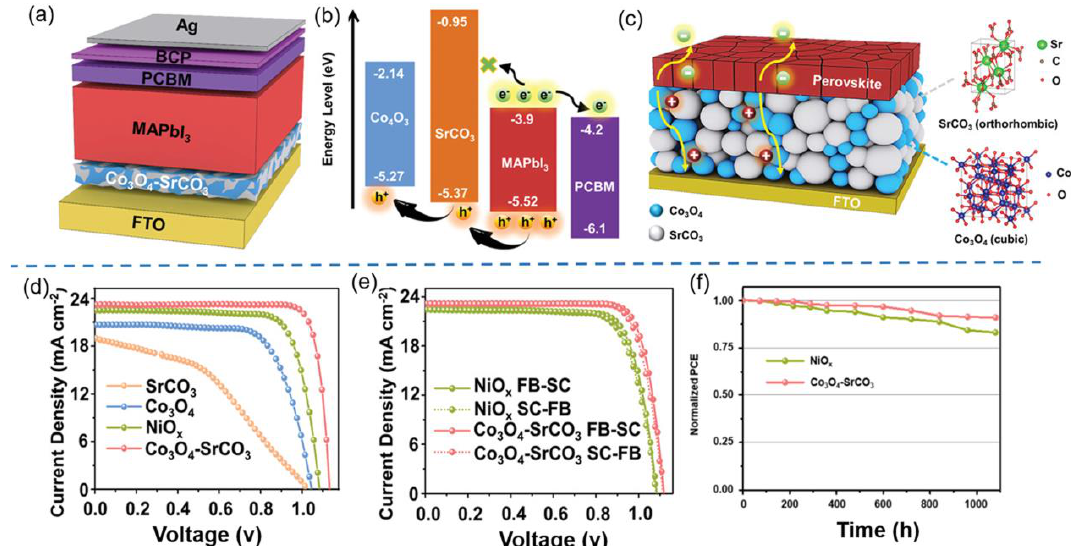
Figure 12. ( a ) Structural and ( b ) energy level diagrams of Co 3 O 4 -SrCO 3 HTL-based PSC; ( c ) schematic diagram of charge transfer pathways in Co 3 O 4 -SrCO 3 HTL-based PSC; ( d ) J–V curves of PSCs with SrCO 3 , Co 3 O 4 , Co 3 O 4 -SrCO 3 and NiO x as HTLs; ( e ) J–V curves of PSCs with Co 3 O 4 -SrCO 3 and NiO x as HTLs under forward and reverse scan directions; ( f ) ambient stability of PSCs with Co 3 O 4 - SrCO 3 and NiO x as HTLs. Reproduced from [67], with permission from the Advanced Functional Materials, 2019.